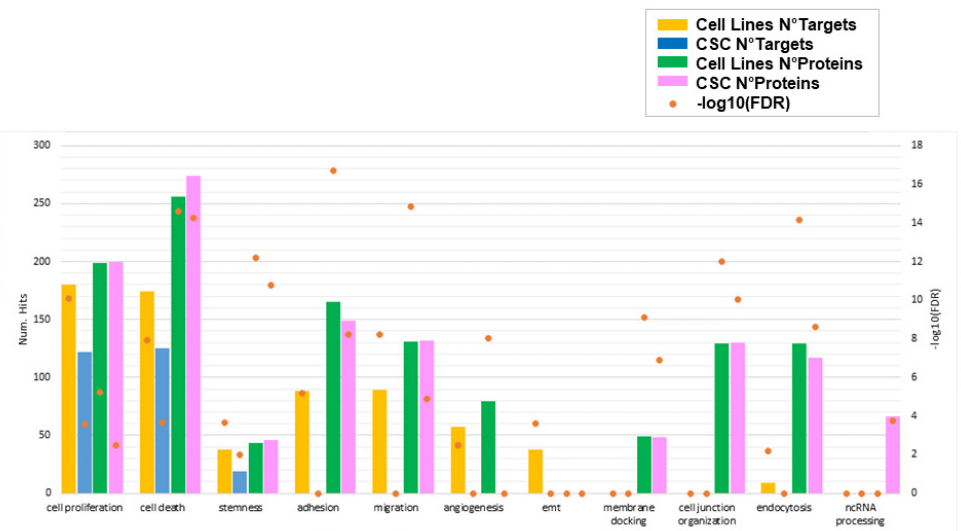
Figure 7. Biological functions enriched by miRNA target genes and/or proteins for sEVs secreted by GBM cell lines and primary CSCs. For each function of interest, the number of target genes and/or proteins enriching that process is plotted in different colors for GBM cell lines and CSCs. Orange points represent the statistical significance of the enrichments (FDR, in log10 scale). Only significant enrichments are shown (FDR cutoff: 0.01).